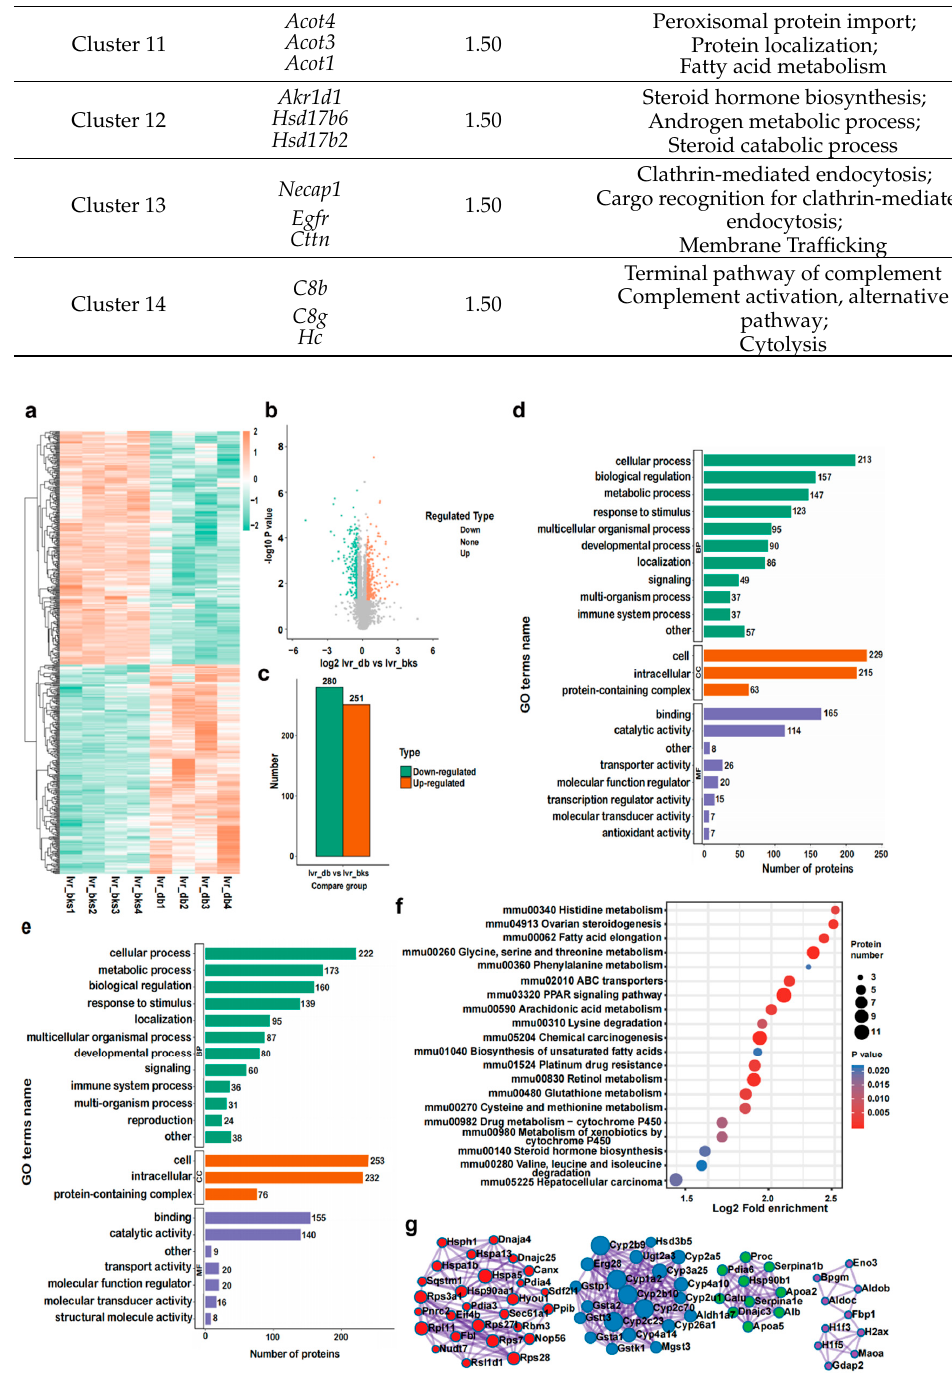
Figure 4. Identification and bioinformatics analysis of hepatic DEPs in db / db mice compared with bks mice. ( a ) Heatmap, ( b ) volcano, and ( c ) histogram depicting the distribution of the hepatic DEPs in db / db mice compared with bks mice. GO (BP) analysis of ( d ) the upregulated proteins and ( e ) downregulated hepatic proteins in db / db mice compared with bks mice. ( f ) KEGG pathway analysis of upregulated DEPs in the mouse liver. ( g ) PPI network of the optimized upregulated and downregulated DEPs in the mouse liver.